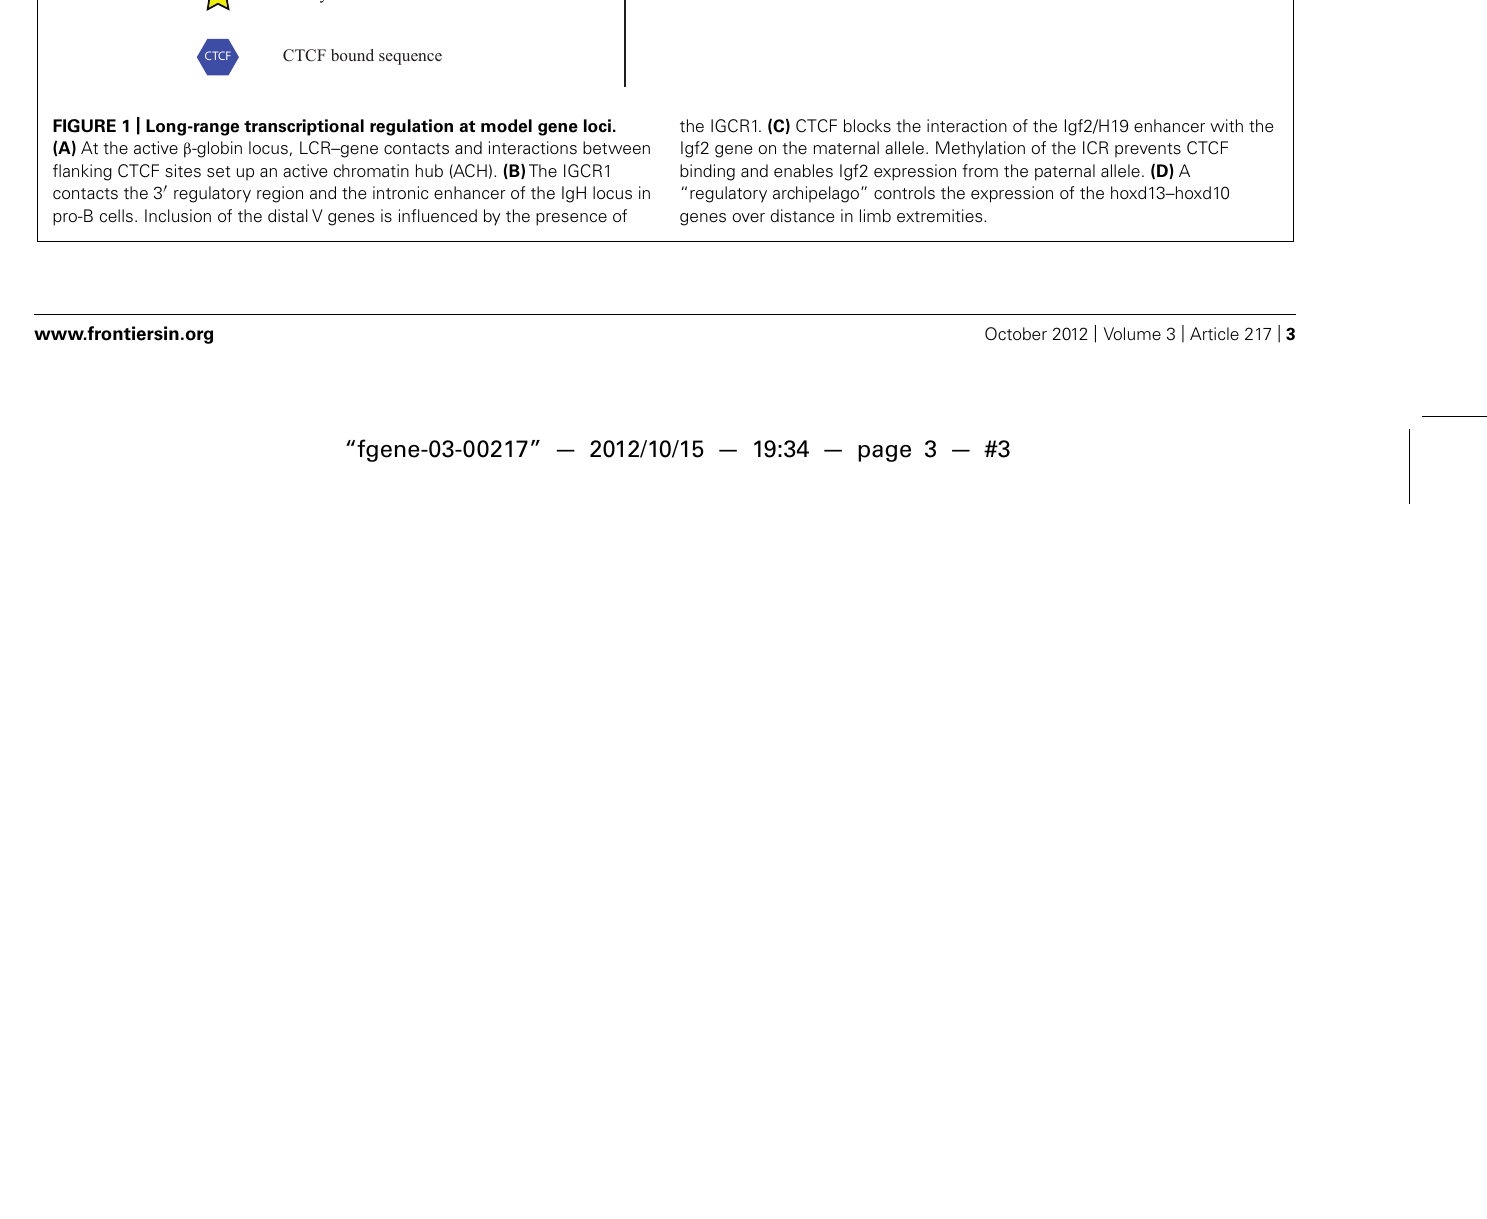
the IGCR1. (C) CTCF blocks the interaction of the Igf2/H19 enhancer with the Igf2 gene on the maternal allele. Methylation of the ICR prevents CTCF binding and enables Igf2 expression from the paternal allele. (D) A “regulatory archipelago” controls the expression of the hoxd13–hoxd10 genes over distance in limb